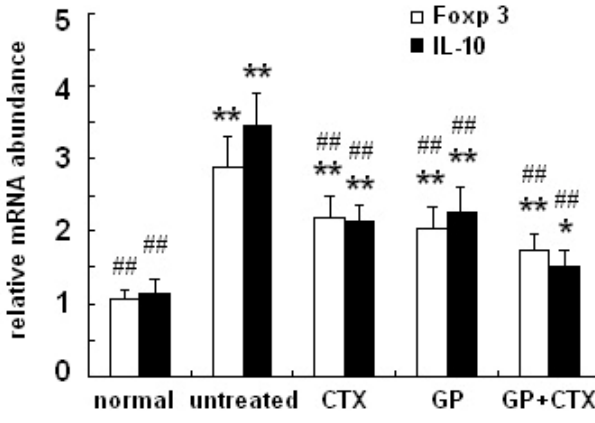
Figure 3. Effects of GP on the mRNA expression of Foxp3 and IL-10 in the lymph nodes. Foxp3 and IL-10 mRNA expressions were determined using real time-PCR. GAPDH was used as the normal control. All experiments were performed three times. * P <